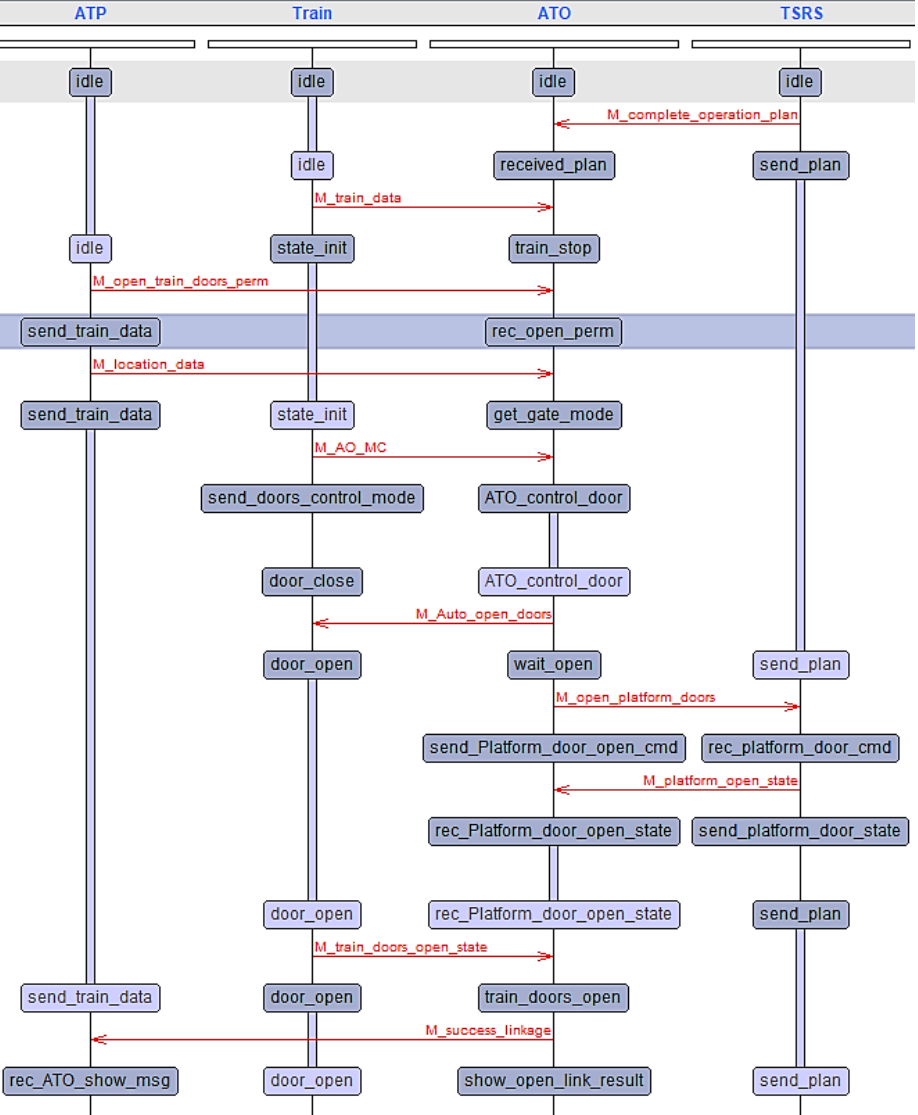
Figure 16. The information interaction relation in the linkage control scenario of train doors and platform doors.